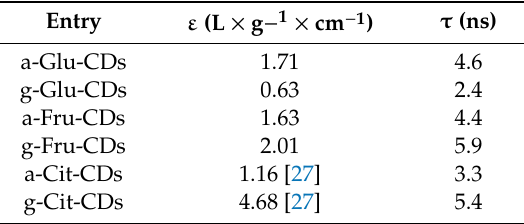
Figure 5. Time-resolved photoluminescent (PL) measurements of CDs. Table 1. Mass extinction coe ffi cients ( ε ) for CDs calculated at 365 nm and lifetime of the excited states ( τ